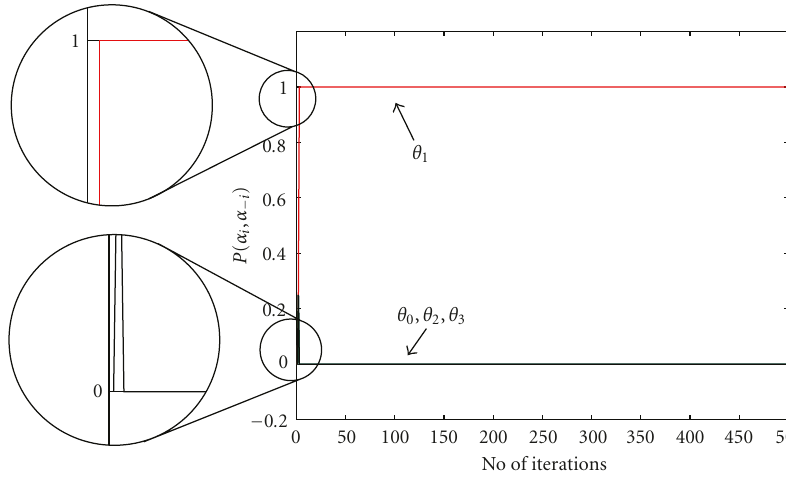
Figure 10: The convergence of the rate-matching algorithms—user 1.